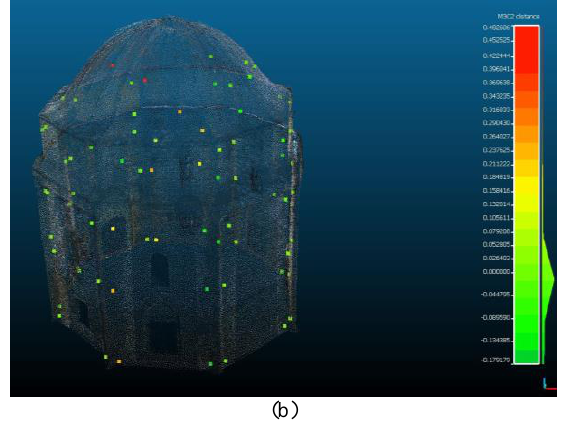
Figure 9: (a) The SfM reconstructed dense point cloud (here subsampled for visualization purposes) and (b) ZED mesh nodes error with respect to the GCPs (in m).